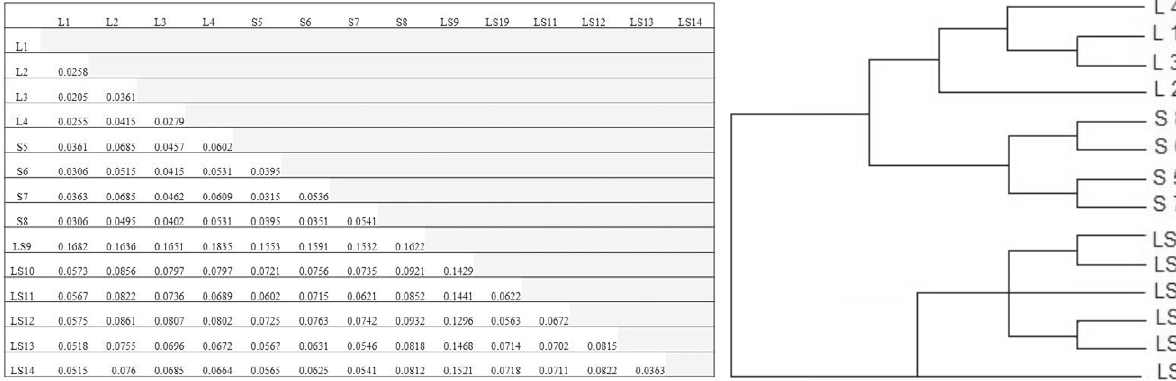
Fig. 5. Diagonal matrix of the genetic distances and Neighbour-joining dendogram showing the genetic relationship among 14 specimens of the three studied genotypes (L, S and